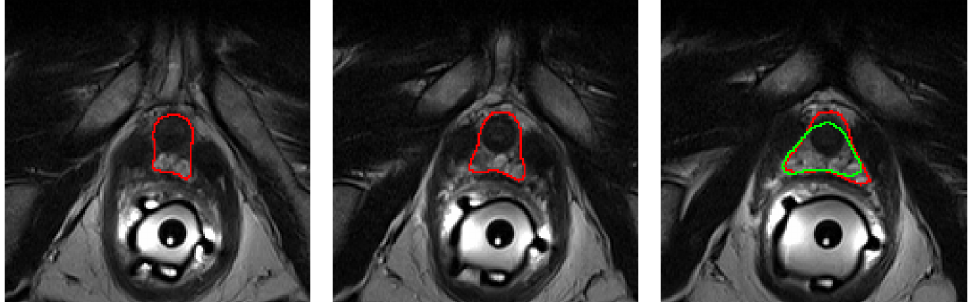
Figure 7. Worst HD95 (7.2 mm) of all MR test datasets. Two slices from the apex ( left and center ) are missed by the algorithm, hence amounting to a minimum of 2 from the segmentation errors commited in the third slice ( right